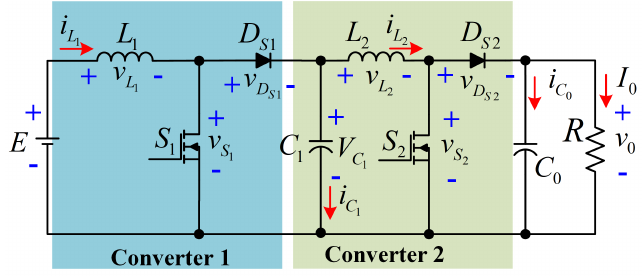
Figure 1. Quadratic boost converter with series power